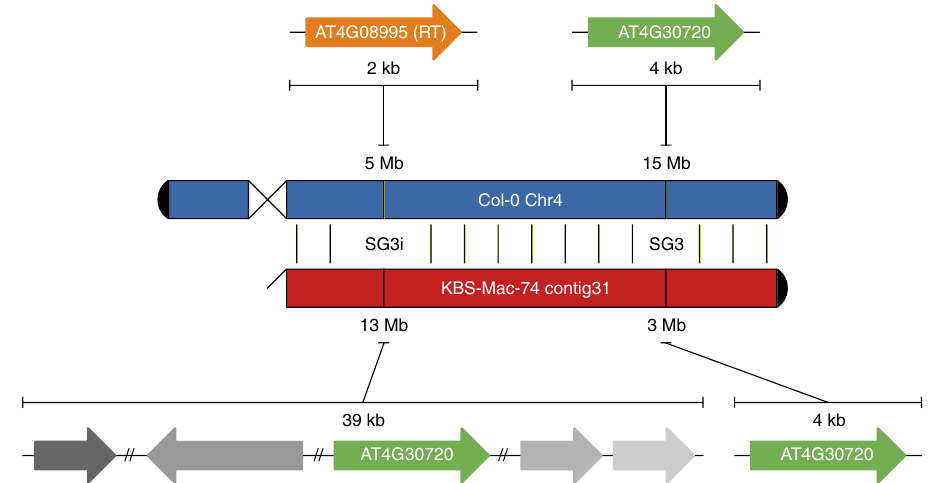
Fig. 4 Resolution of the At4g30720 duplication using the KBS-Mac-74 ONTmin genome. Col-0 only has one copy of At4g30720 on the distal end (15 Mb) of chromosome 4 (Chr4). KBS-Mac-74 (ONTmin) assembly has two copies of At4g30720; one at the beginning of contig 31 that corresponds to the SG3 QTL location, and one at the distal end of contig 31 that overlaps with the SG3 interacting (SG3i) region in the middle of chromosome 4. At the SG3i locus, the Col-0 gene At4g08995 (889 bp), which is annotated as a transposable element (RT; putative reverse transcriptase), is replaced in the KBS-Mac-74 ONTmin assembly with a 39-kb expansion that includes a duplicated copy of At4g30720. Fragments of the transposable element (different gray arrows) are scattered across the KBS-Mac-74 region consistent with several rounds of transposition resulting in this complex rearranged